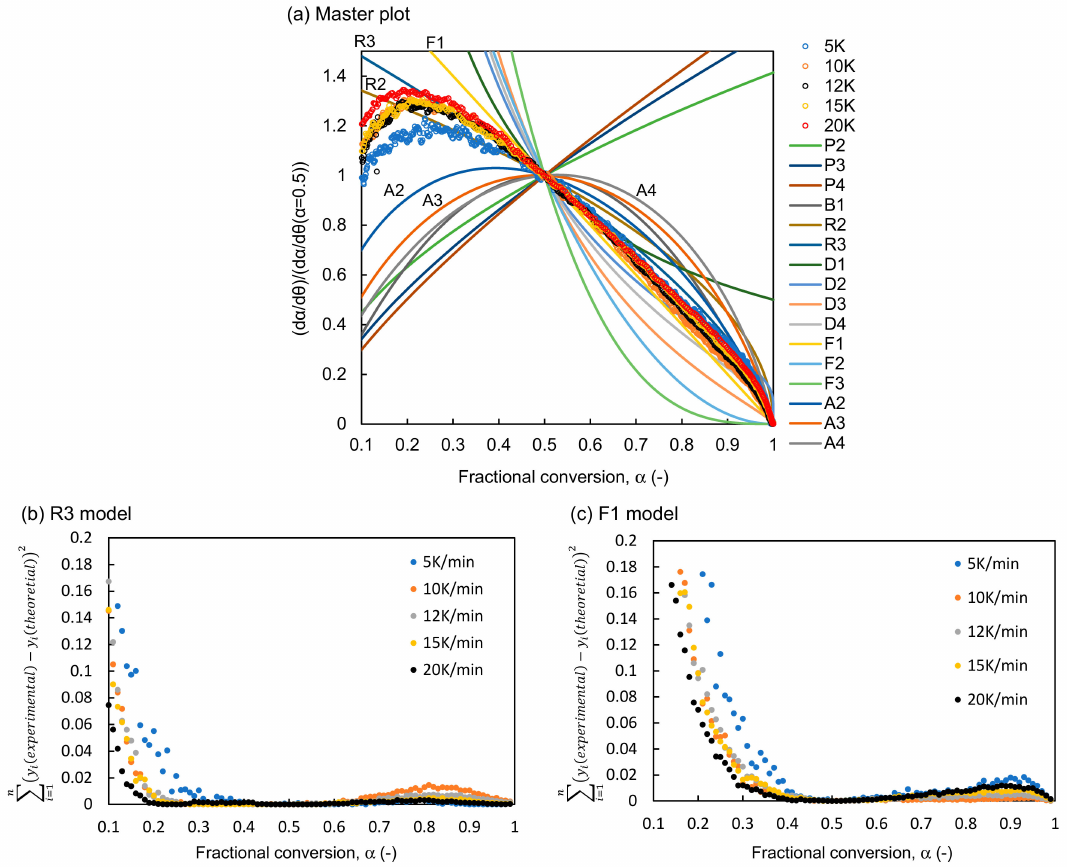
Figure 8. ( a ) Comparison of experimental kinetic data (circles) for the as-prepared sample and predicted reaction model (curves) against variations of fractional conversion of α . To estimate which reaction model fitted the experimental data, all possible theoretical models were examined. The RSS values of estimated ( b ) R3 and ( c ) F1 reaction models against variations of fractional conversion for all heating